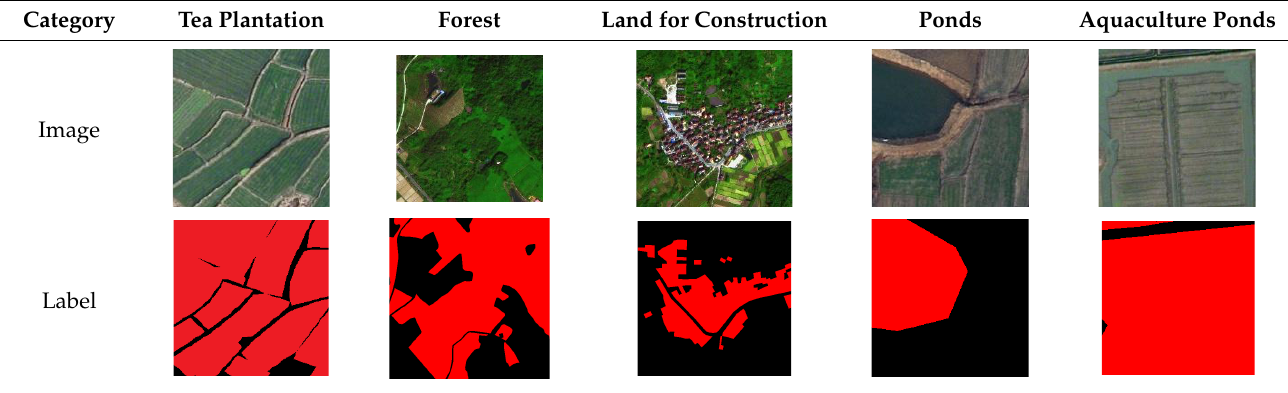
Table 3. Model samples.